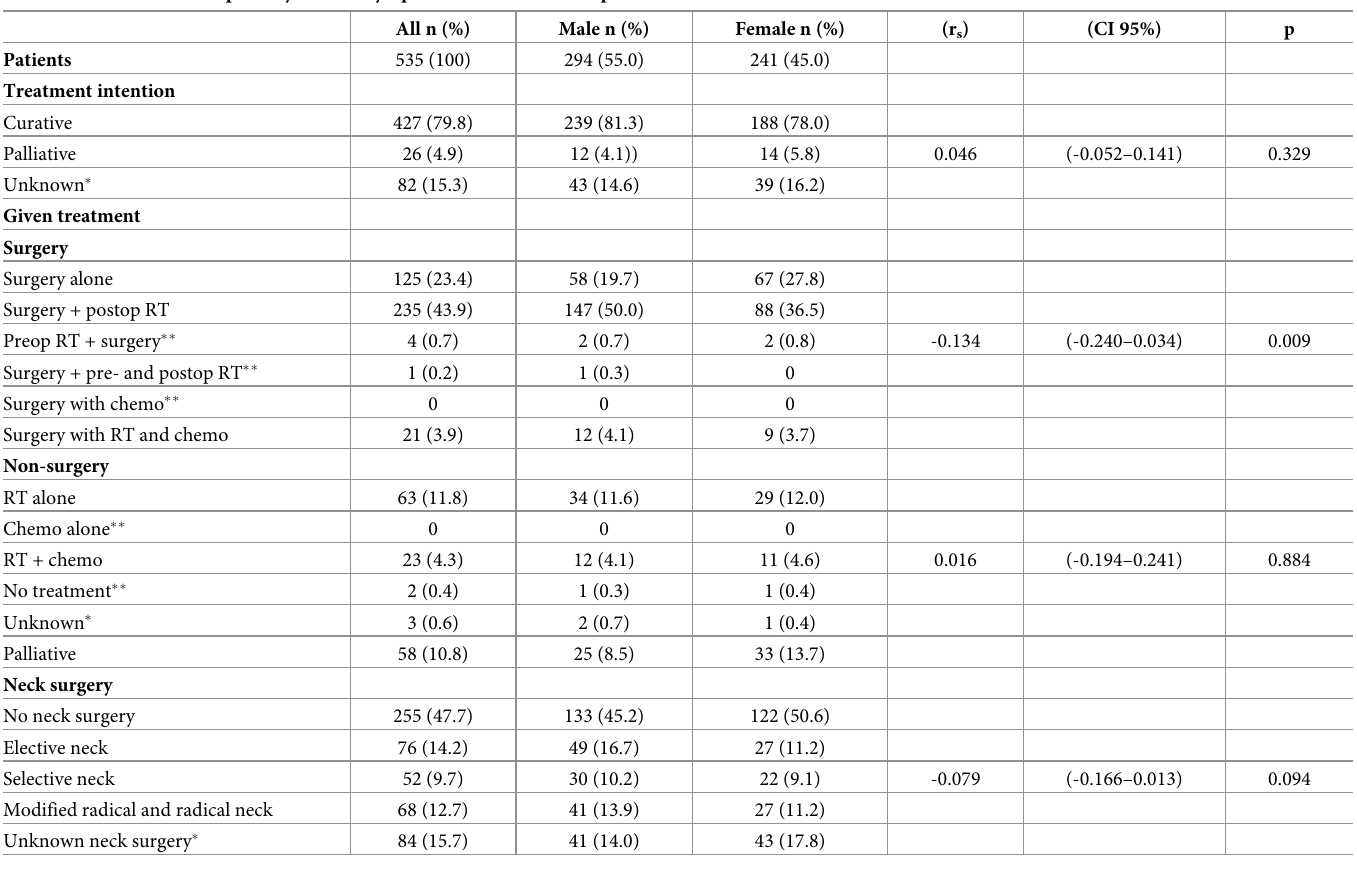
Table 3. Treatment of 535 primary oral cavity squamous cell carcinoma patients